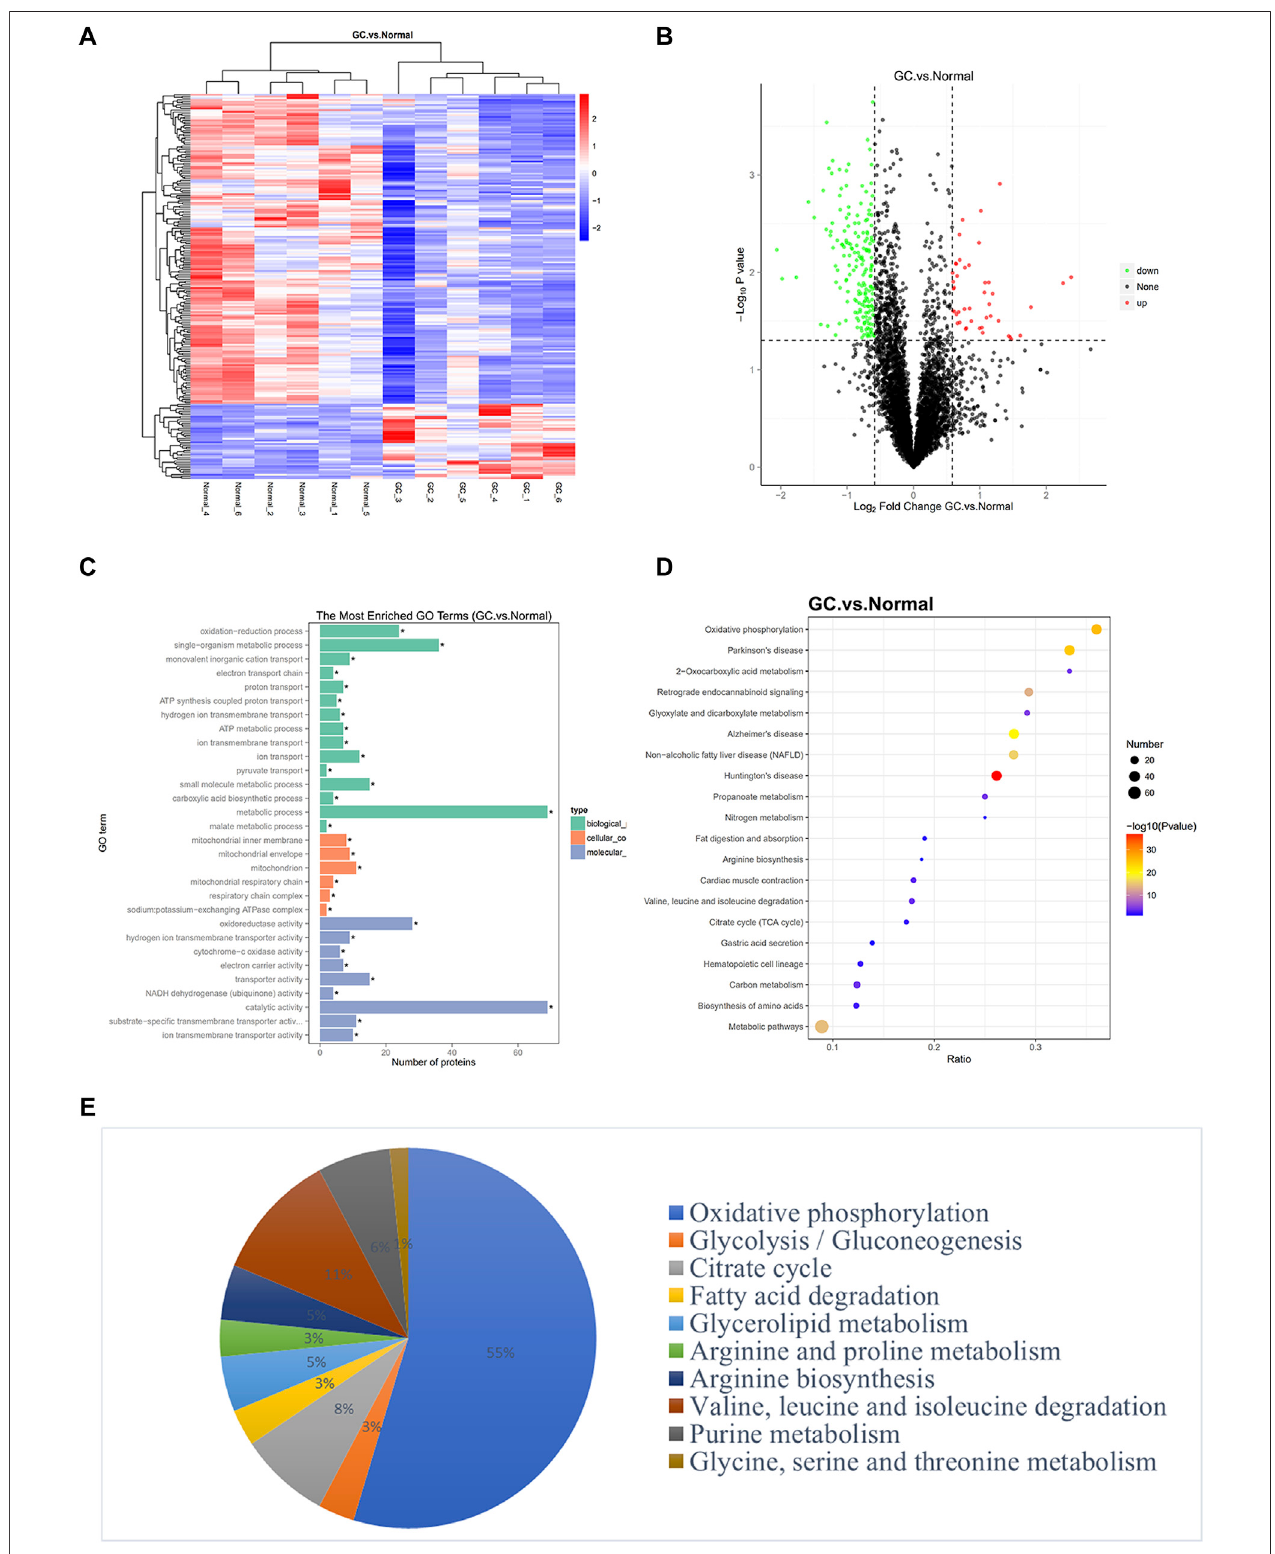
FIGURE 1 | Identi fi cation of genes related to metabolic pathways through proteomics. (A) A cluster heat map presented the signi fi cantly dysregulated proteins in GC tissues related topairednormaltissues.The red and blue stripsrepresented highand low expression, respectively. (B) Volcano plot fi ltering ofdifferently expressed proteins